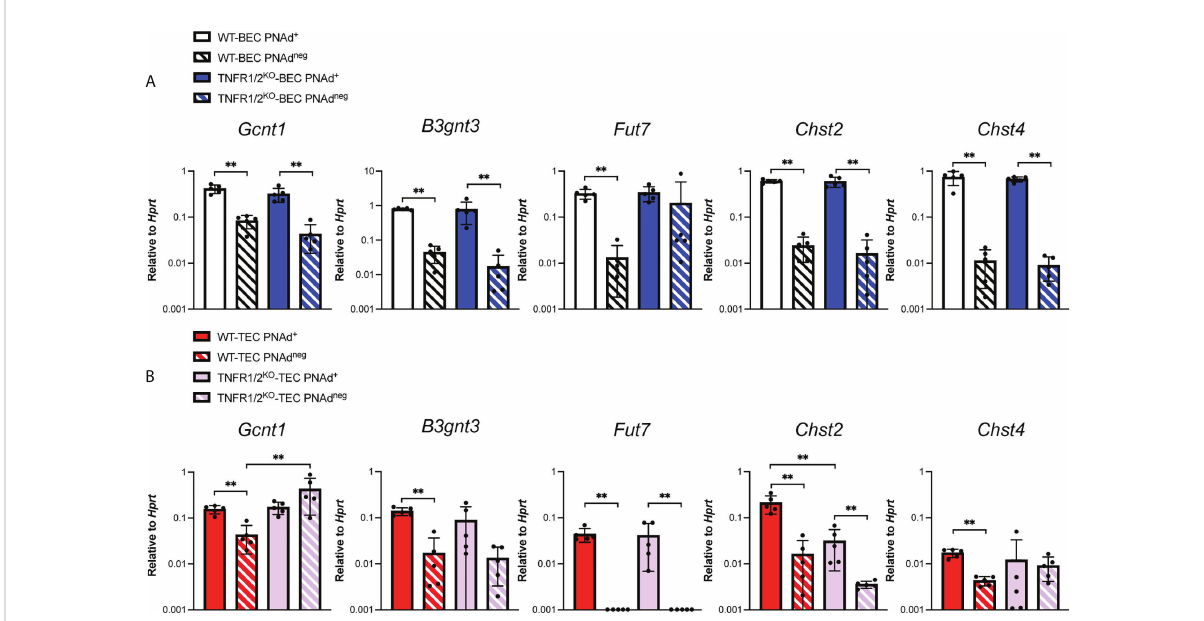
FIGURE 6 Tumor necrosis factor receptor signaling regulates Chst2 expression in PNAd + TEC. C57BL/6 WT or TNFR1/2 -/- mice were I.P. injected with B16-OVA cells and tumors were harvested 14 days after implantation. LN were harvested from non-tumor-bearing mice. (A, B) Endothelial cells were sorted from CD45 + depleted LN and I.P. tumor suspensions, and the expression levels of indicated RNA transcripts were determined by qPCR, as described in Methods. Data from one experiment presented as 2 - D CT relative to Hprt, n=5 LN or I.P. tumors per group. (A, B) Results are mean ± SD analyzed by unpaired Welch ’ s t-test. **p<0.01, all other paired bar comparisons are not signi fi cant (p>0.05) and have been omitted for